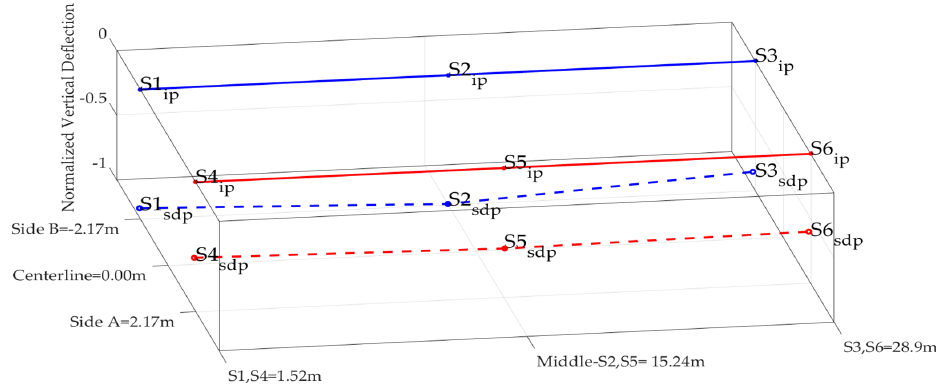
Figure 21. 5th Identified mode shape-2nd bending with sensor 4 as reference at 8.54 Hz.